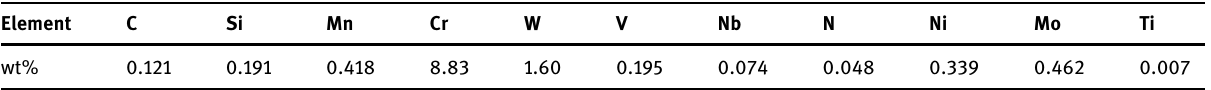
Table 1: Chemical composition of P92 steel ( wt% ) Element C Si